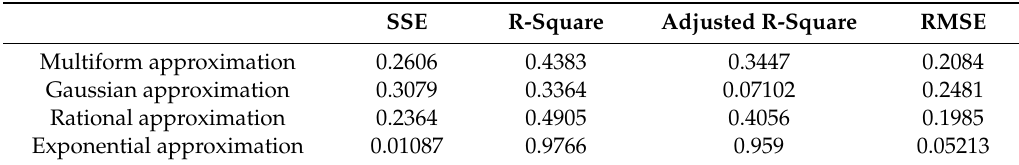
Table 3. List of parameters after fitting experimental.